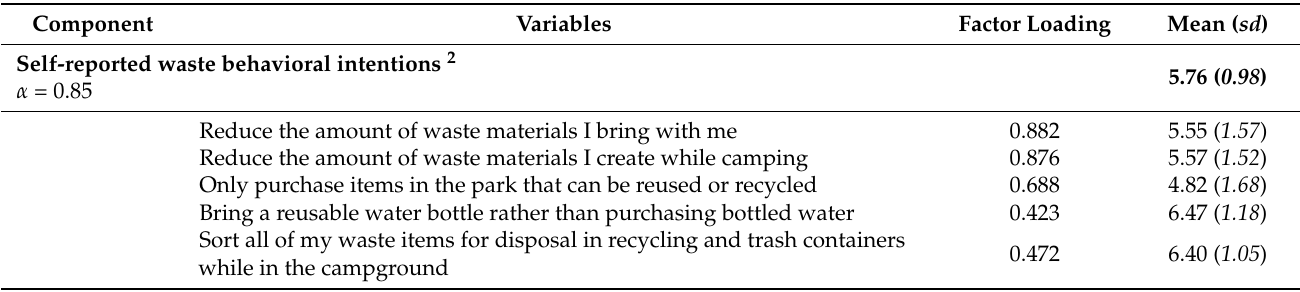
Table 1. Intentions of Campground Visitors 1 .